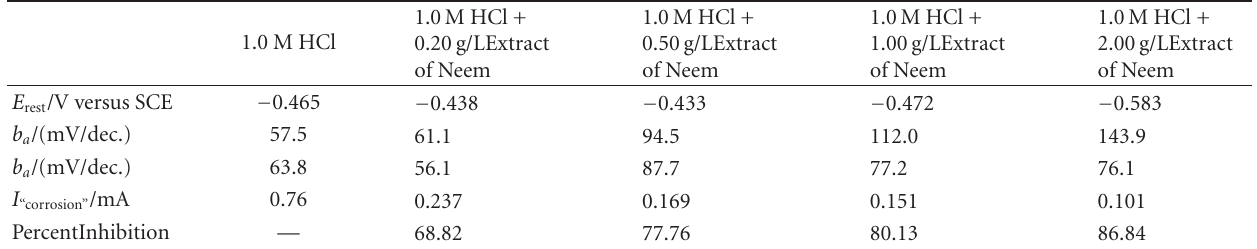
Table 2: Tafel corrosion currents and percentage inhibitions of the aqueous extract of Neem leaves at various concentrations in 1.0 M HCl at room temperature.